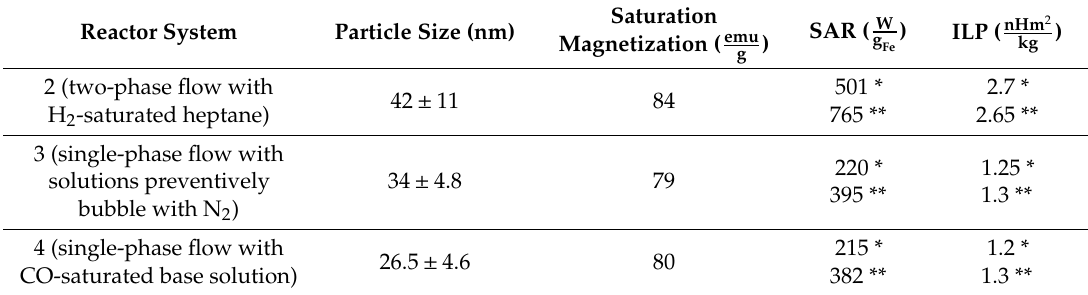
Table 1. Summary of particle size, saturation magnetization, SAR and ILP of the particles produced using Reactor Systems 2, 3 and